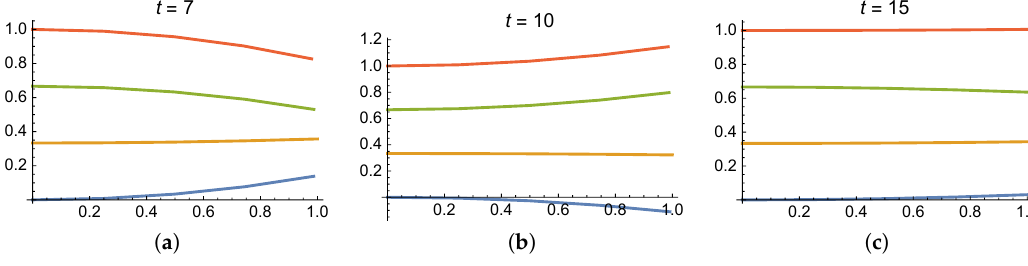
Figure 7. Three snapshots of the configuration of the array of four coupled filaments with curvature coupling. Time ( a ) t = 7s; ( b ) t = 10s; and ( c ) t =